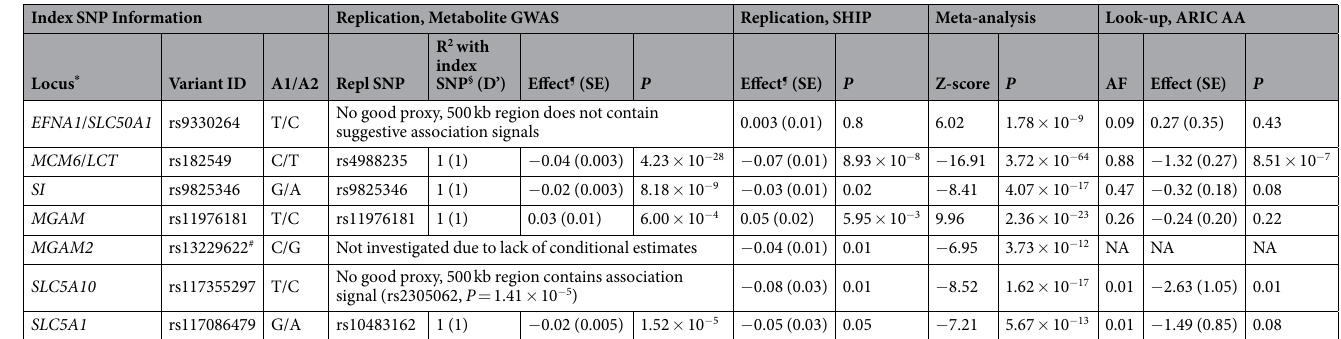
Table 3. Independent replication results for the seven identified index variants in EA populations and evaluation among African Americans. * The gene closest to the variant and other candidate genes are listed (index gene). § R 2 information was extracted from 1000 Genomes Project Phase 3 in European (EUR) population. ¶ Effect sizes in the replication studies are based on semi-quantitative metabolomics measurements of 1,5-AG 9 and are thus on a different scale compared to the discovery estimates. # rs13229622 is an independent SNP with genome-wide significant association with 1,5-AG found through conditional analysis. It was not investigated in the metabolite GWAS because available association results were not conditional estimates. A1 is the effect allele, i.e. the allele for which effect estimates are provided. Abbreviations: Repl SNP = replication SNP; AF = effect allele frequency; SE = standard